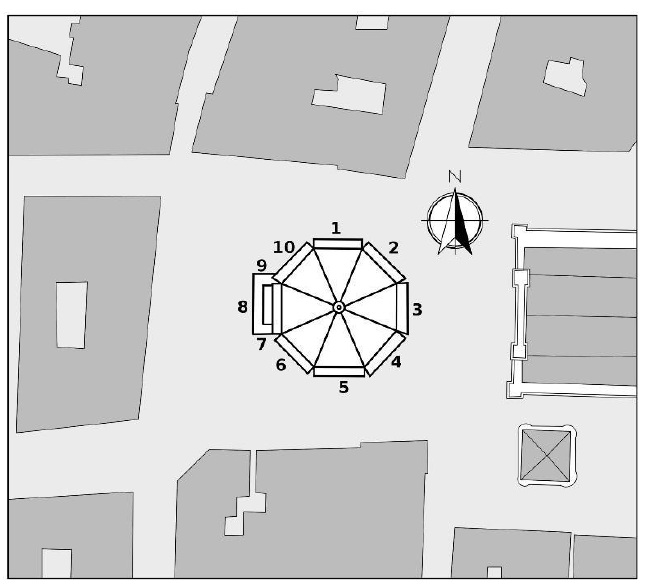
Figure 2. The octagonal plan of San Giovanni Baptistery in Florence. The numbering of the sides is reported. Table 1. List of the collected stone materials samples, their localization on the monument, and the analytical methodologies applied in the investigation.